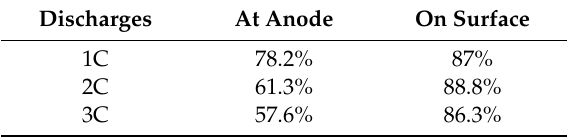
Table 4. The cooling e ffi ciencies at the anode and on the surface of the cell module during discharges. Discharges At Anode On